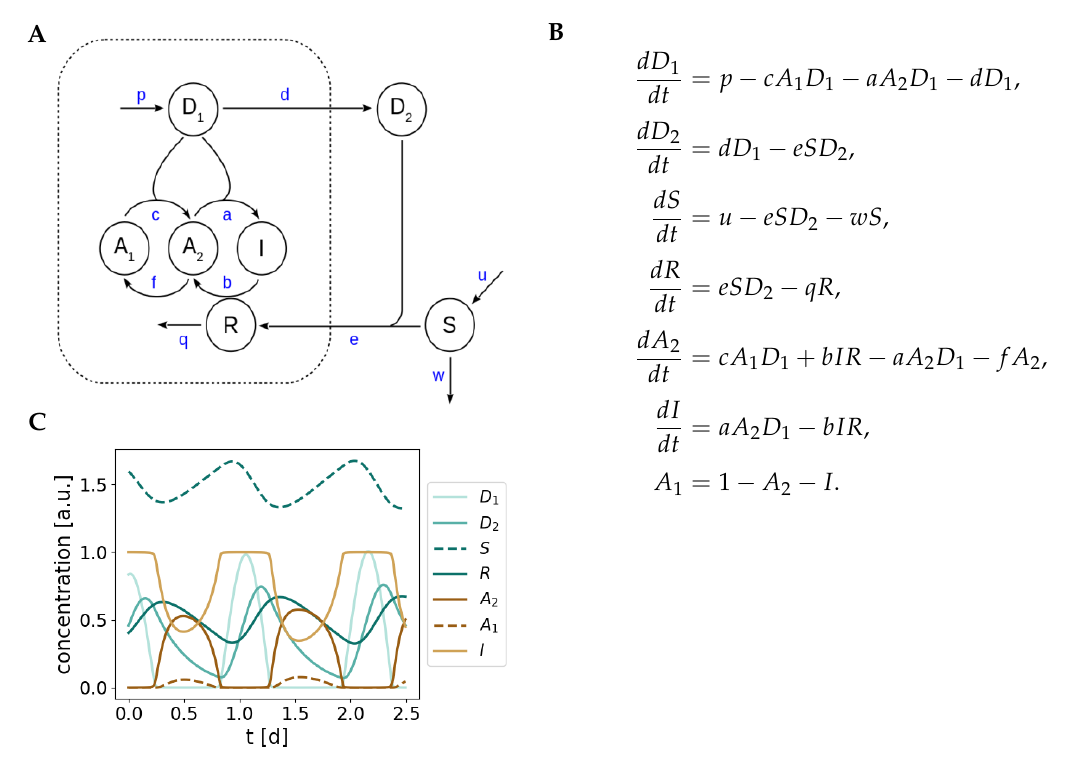
Figure A2. A 6-ODE model for circadian redox oscillations. ( A ) The 10-ODE detailed model is Prx3-SO 2 H; D 1 , mitochondrial H 2 O 2 ; D 2 , cytosolic H 2 O 2 ; S , cytosolic Srx; and R , mitochondrial Srx.